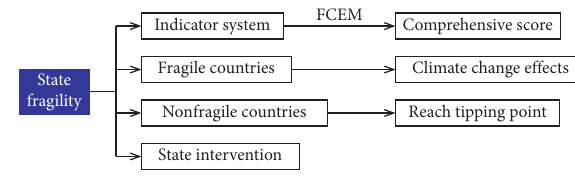
Figure 1: Overall thinking